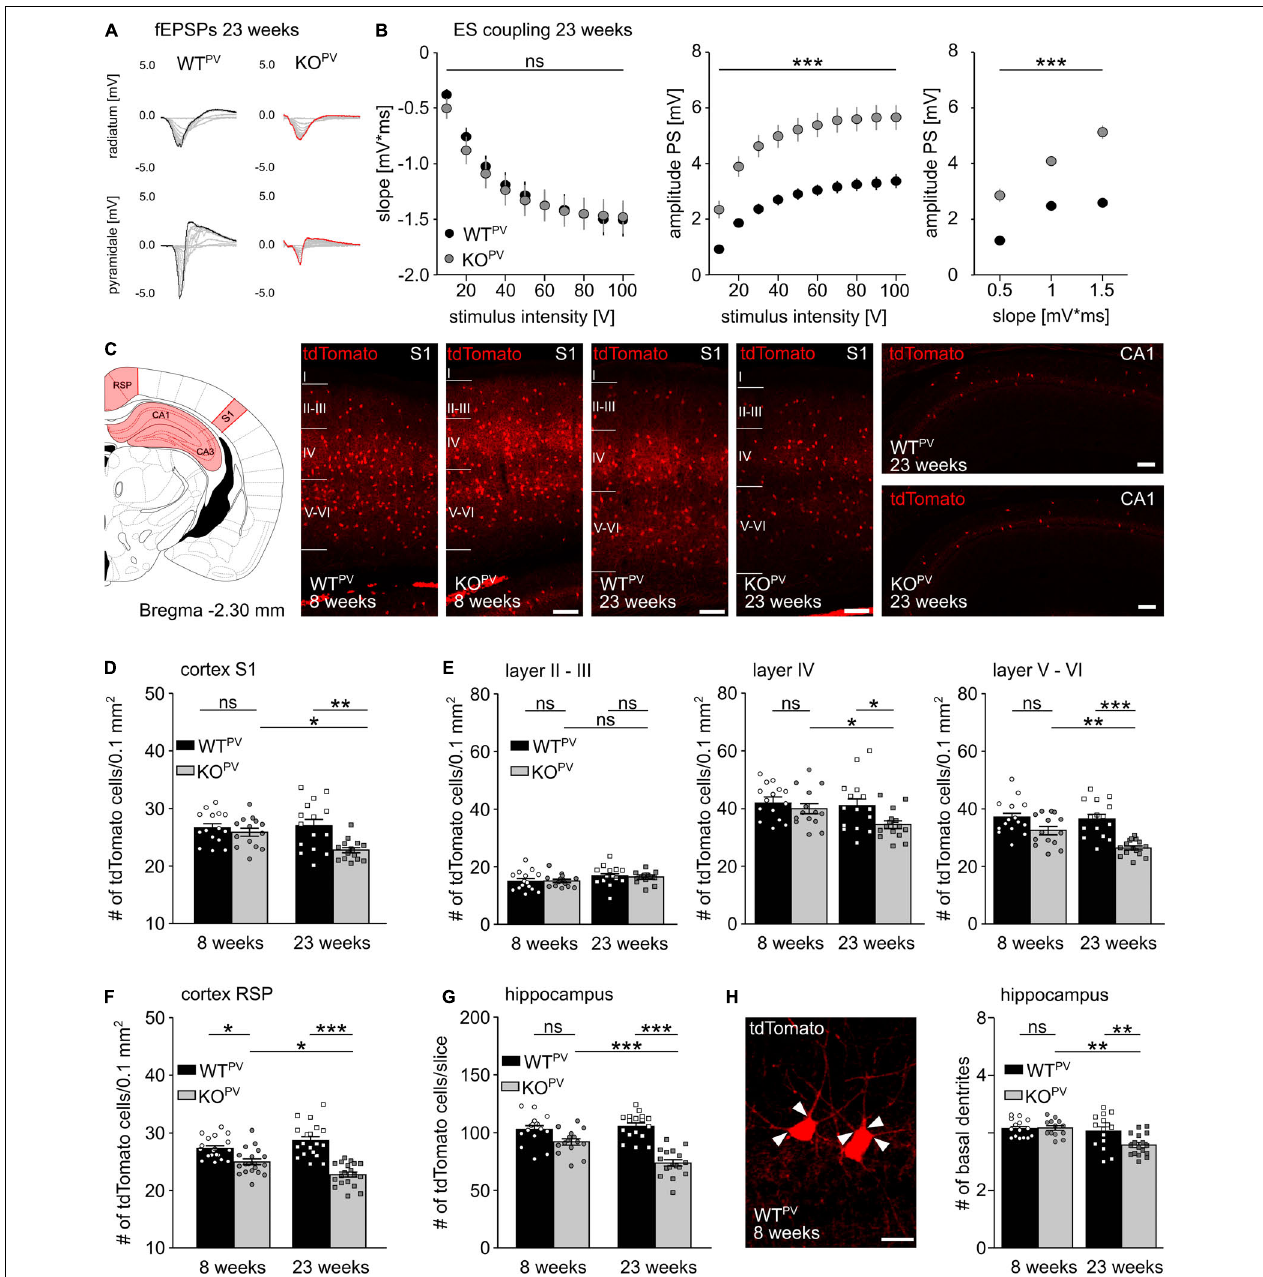
FIGURE 5 | Loss of PV-INs in KCC2 KO PV mice. (A) Representative examples of fEPSPs recorded in the stratum radiatum and stratum pyramidale of 23-week-old WT PV and KCC2 KO PV mice. (B) E-S-coupling is increased in 23-week-old KCC2 KO PV mice ( n = 24/33 slices from N = 5/5 mice; 2-way ANOVA repeated measure; Bonferroni post-test; *** p < 0.0001). (C) Illustration of the brain regions (red) for the quantification of tdTomato-positive neurons. Representative images of tdTomato-positive cells from the somatosensory cortex (S1) of WT PV (left) and KCC2 KO PV (right) mice at 23 weeks of age and hippocampus CA1 of 23-week-old mice. Scale bars 100 µ m. (D) Number of tdTomato-positive cells per 0.1 mm 2 of a 30 µ m thick section of S1 of 8- and 23-week-old KCC2 WT PV and KO PV mice ( n = 15/15 slices; N = 5/5 mice; 1-way ANOVA; Bonferroni post-test; * p < 0.05; ** p < 0.01). (E) Number of tdTomato-positive cells per 0.1 mm 2 and layer of a 30 µ m thick section of S1 ( n = 15/15 slices; N = 5/5 mice; 1-way ANOVA; Bonferroni post-test; ns not significant; * p < 0.05; ** p < 0.01; *** p < 0.001). (F) Number of tdTomato-positive cells per 0.1mm 2 of a 30 µ m thick section of the retrosplenial cortex (RSP) of 8- and 23-week-old WT PV and KCC2 KO PV mice ( n = 17/15 slices; N = 5/5 mice; 1-way ANOVA; Bonferroni post-test; * p < 0.05; *** p < 0.0001). (G) Quantification of tdTomato-positive cells in a 30 µ m thick hippocampal section (Bregma -2.3 mm, 1 hemisphere) of 8- and 23-week-old WT PV and KCC2 KO PV mice ( n = 15/15 slices; N = 5/5 mice; 1-way ANOVA; Bonferroni post-test; *** p < 0.0001). Individual numbers for D-G are provided in Supplementary Table 1 . (H) The number of basal dendrites (arrowheads) of tdTomato-positive neurons in the hippocampus is slightly decreased in 23-week-old KCC2 KO PV mice (WT 8 weeks: 4.2 ± 0.1; KO 8 weeks: 4.2 ± 0.1; WT 23 weeks: 4.1 ± 0.2; KO 23 weeks: 3.6 ± 0.1; n = 15/15 slices from N = 5/5 mice; 1-way ANOVA; Bonferroni‘s multiple comparison test; ** p <